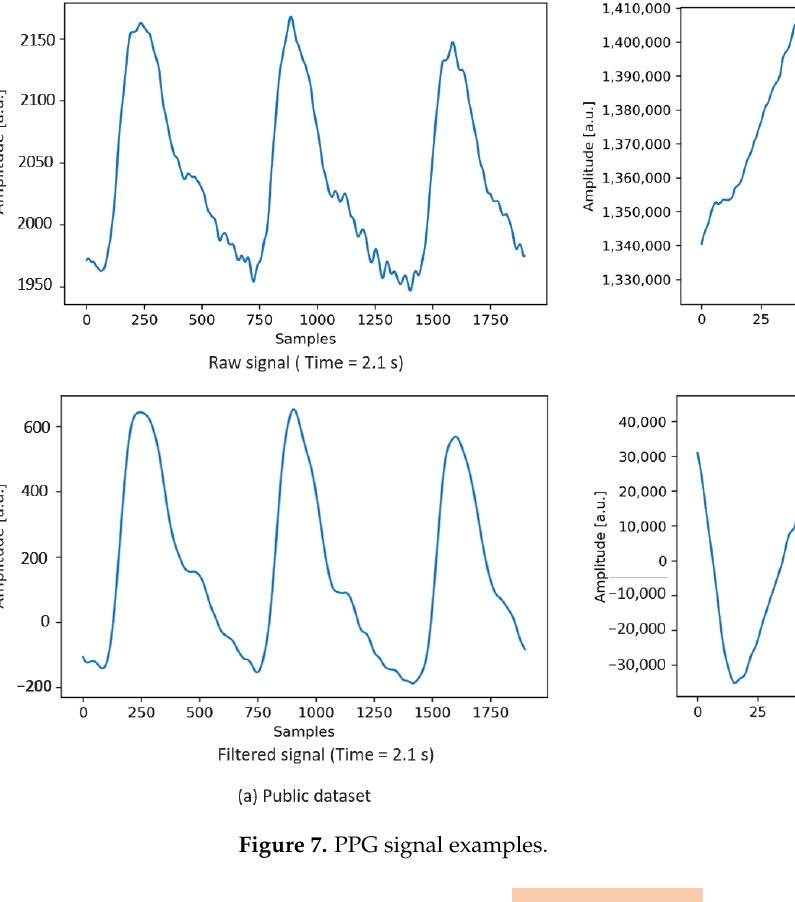
Figure 7. PPG signal examples.